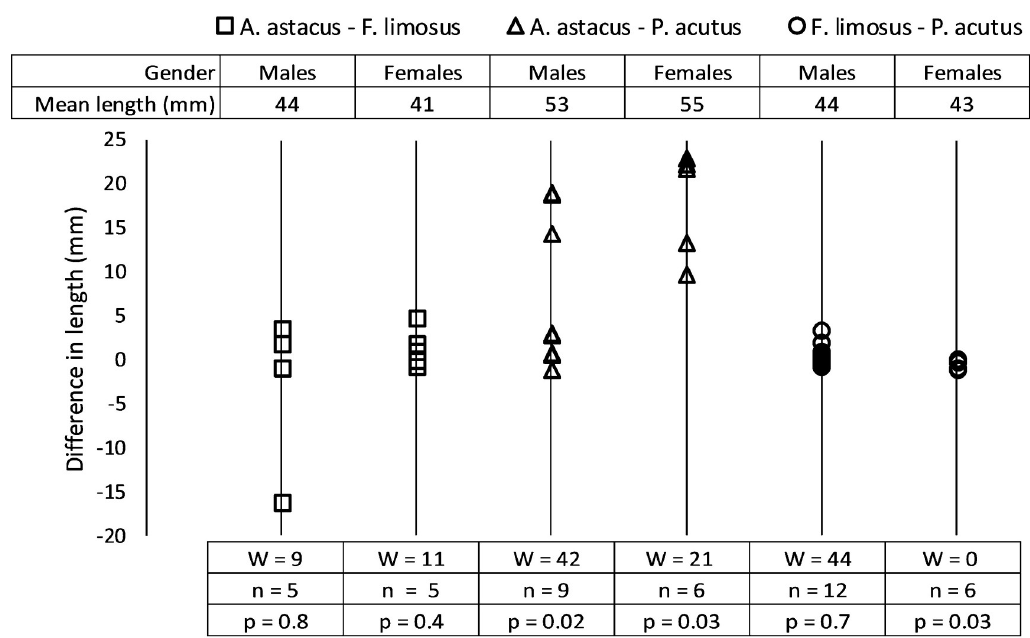
Fig 1. The difference in carapace length between the two interacting crayfish. The difference is positive when the specimen of the species named first in the legend is larger than the specimen of the species named second and negative when it is the other way around. Each data point indicates one interacting pair and the symbols are vertically aligned according to gender and species combination. Outcomes of two-sided Wilcoxon signed rank tests are indicated below the corresponding gender and species combination and the average carapace lengths of the trialled animals are indicated above the data